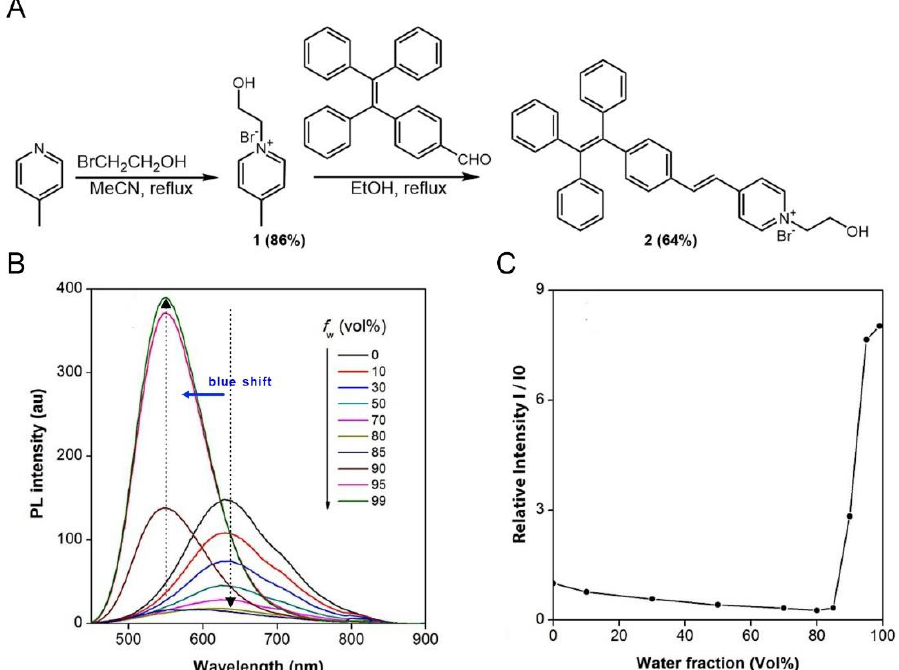
Figure 1. ( A ) Synthesis of molecule 2 (TPE-Py-OH). ( B ) PL spectra of TPE-Py-OH in DMSO/H 2 O mixtures with different water fractions (fw). Concentration: 100 µM; excitation wavelength: 405 nm. ( C ) Plot of PL intensity versus the composition of the DMSO/H 2 O mixtures of TPE-Py-OH.